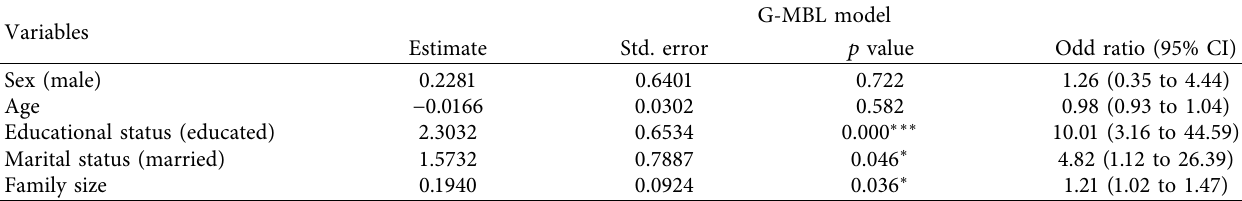
Table 1: Estimates and odds ratio of factors affecting controlled mating systems at Chora